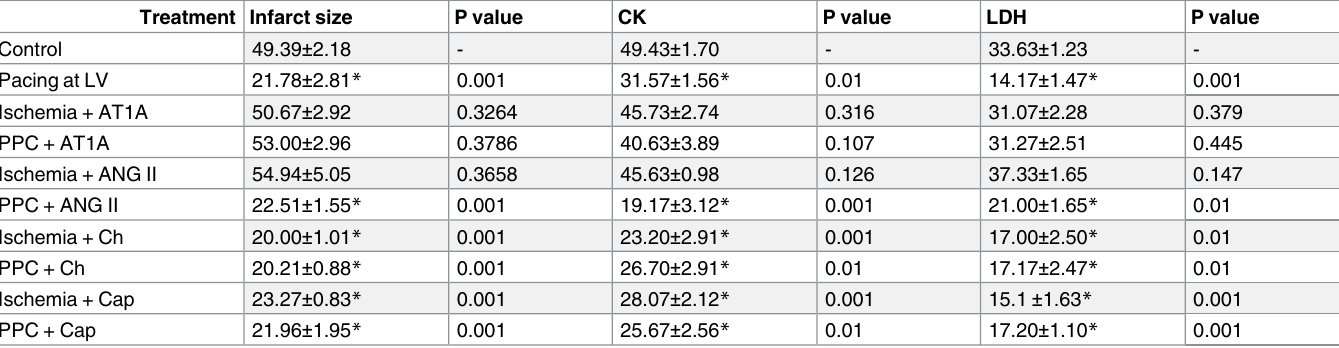
Table 1. Effects of RAS system on the infarct size and heart enzymes levels. Treatment Infarct